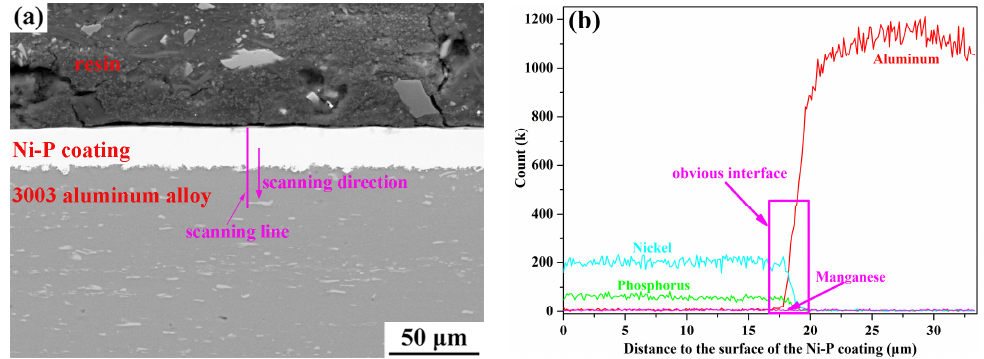
Figure 2. ( a ) Cross ‐ section morphology and ( b ) its elemental distribution of as ‐ deposited Ni ‐ P coating.